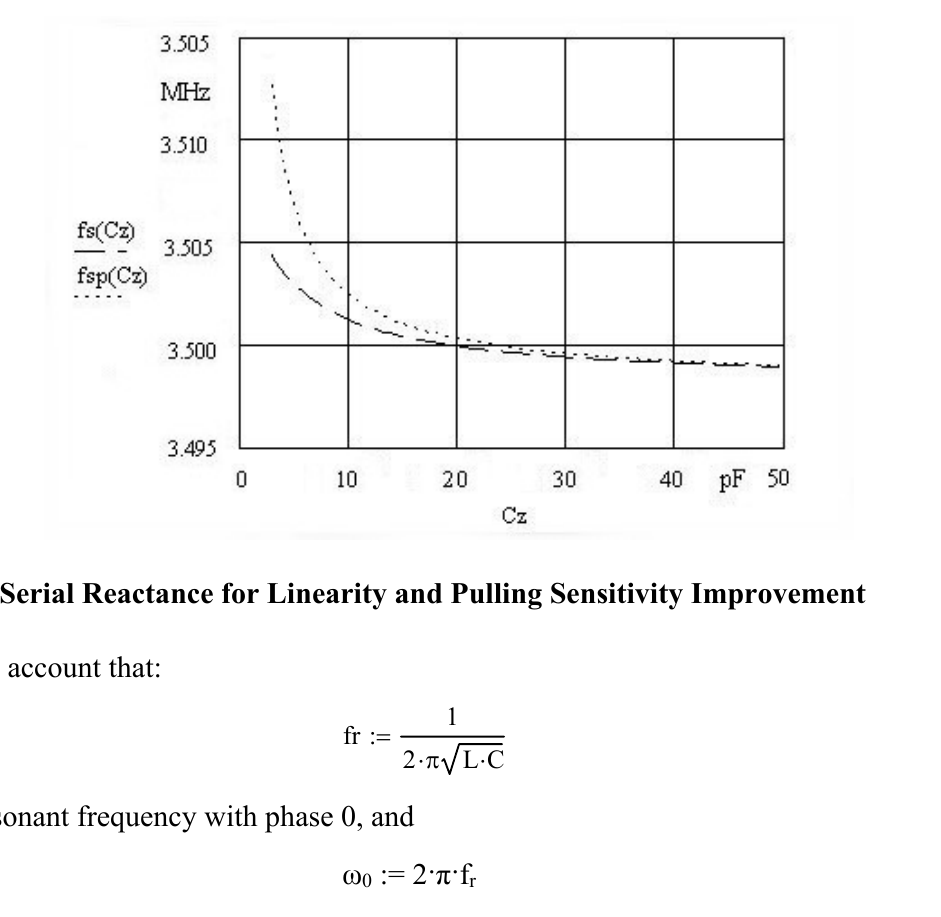
Figure 2. Quartz crystal pulling sensitivity from 3 to 50